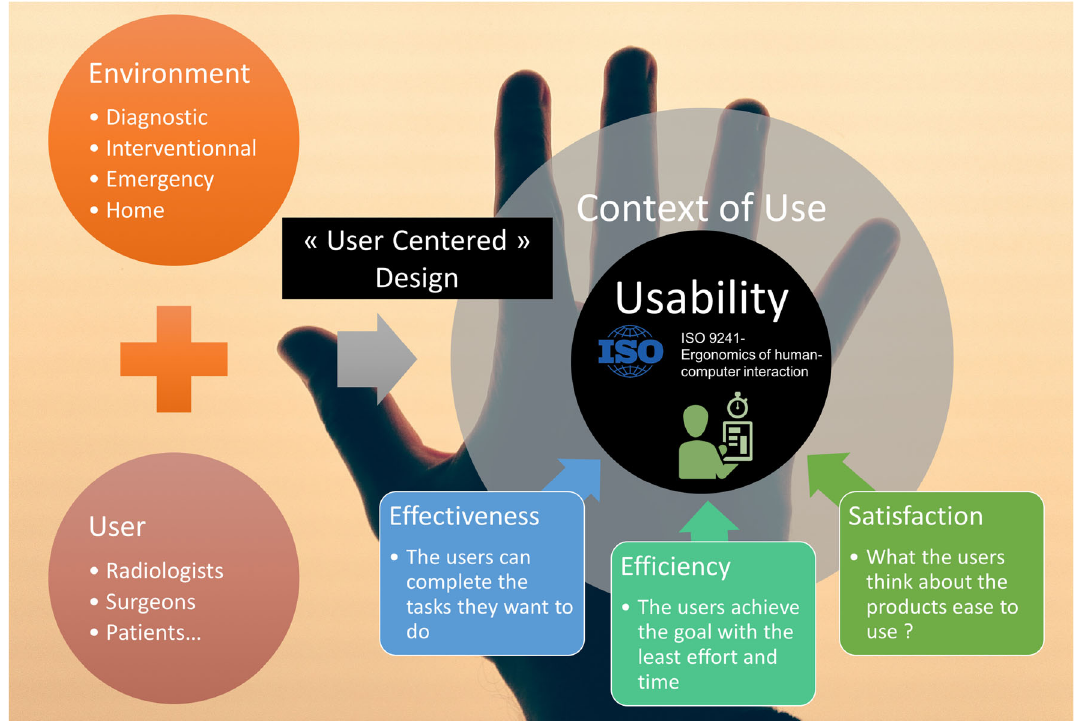
Fig. 1 The usability of a computer user interface (CUI) in radiology is evaluated by three indicators. The UI is designed to maximize the usability in a specified context of use. In medical imaging, the usage context can be defined as a user (the reader of the images) inside his